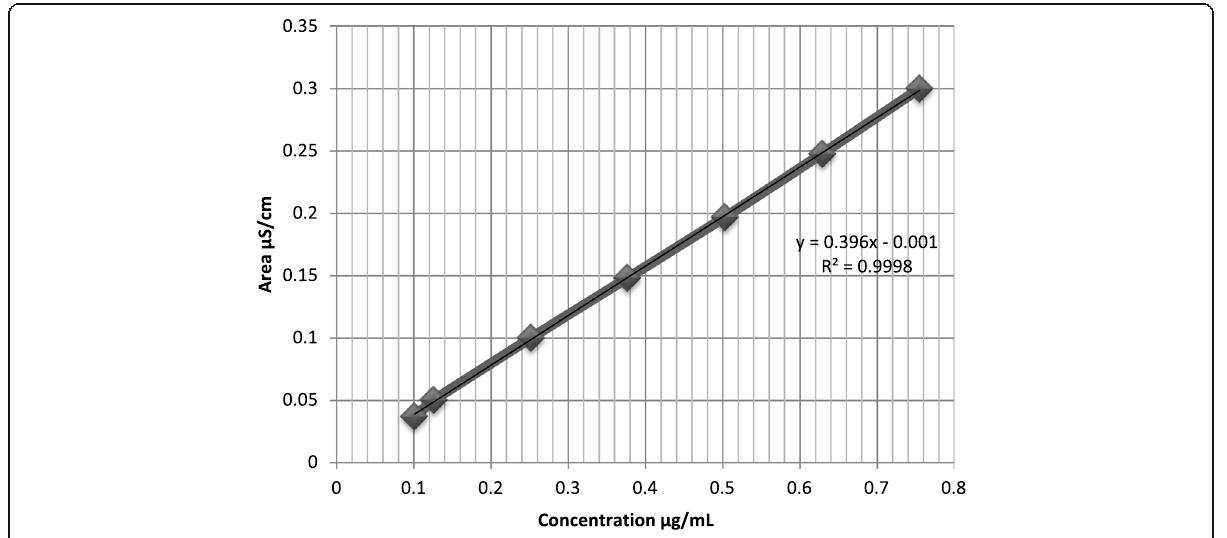
Fig. 7 A typical representative linearity plot (concentration vs area)